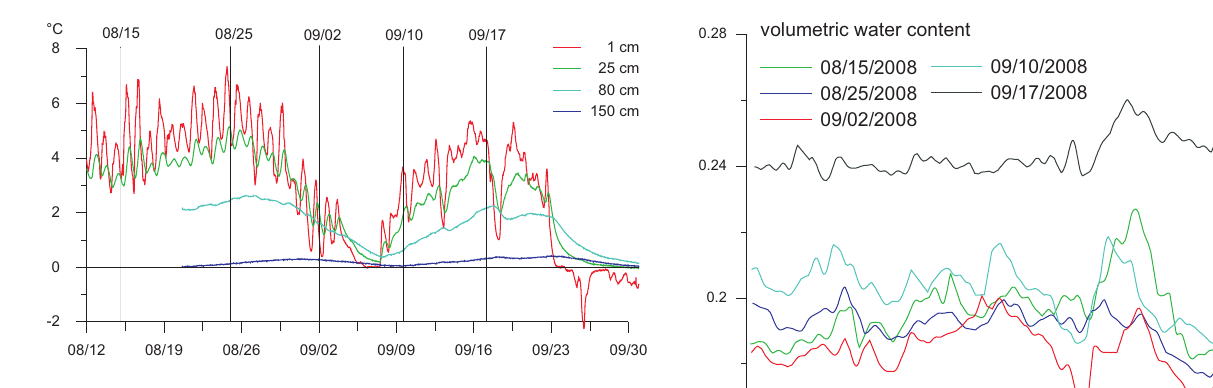
Fig. 6. Temperature profile in the active layer at the position 123.6m of transect T2. The two lower sensors have been added on 20 August 2009. The dates of the radar surveys of transect T2 are indicated as vertical lines.